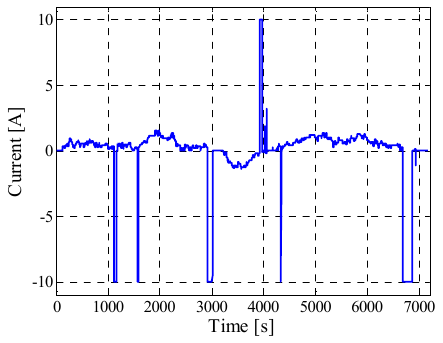
Figure 25. Field-measured current profile used for the verification of the performance model.